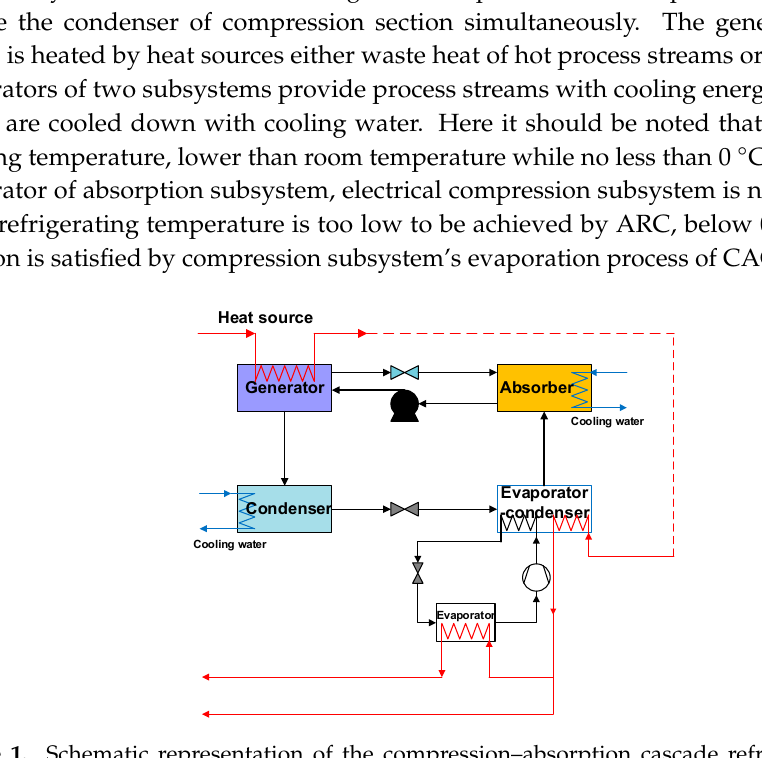
Figure 1. Schematic representation of the compression–absorption cascade refrigeration system (CACRS).